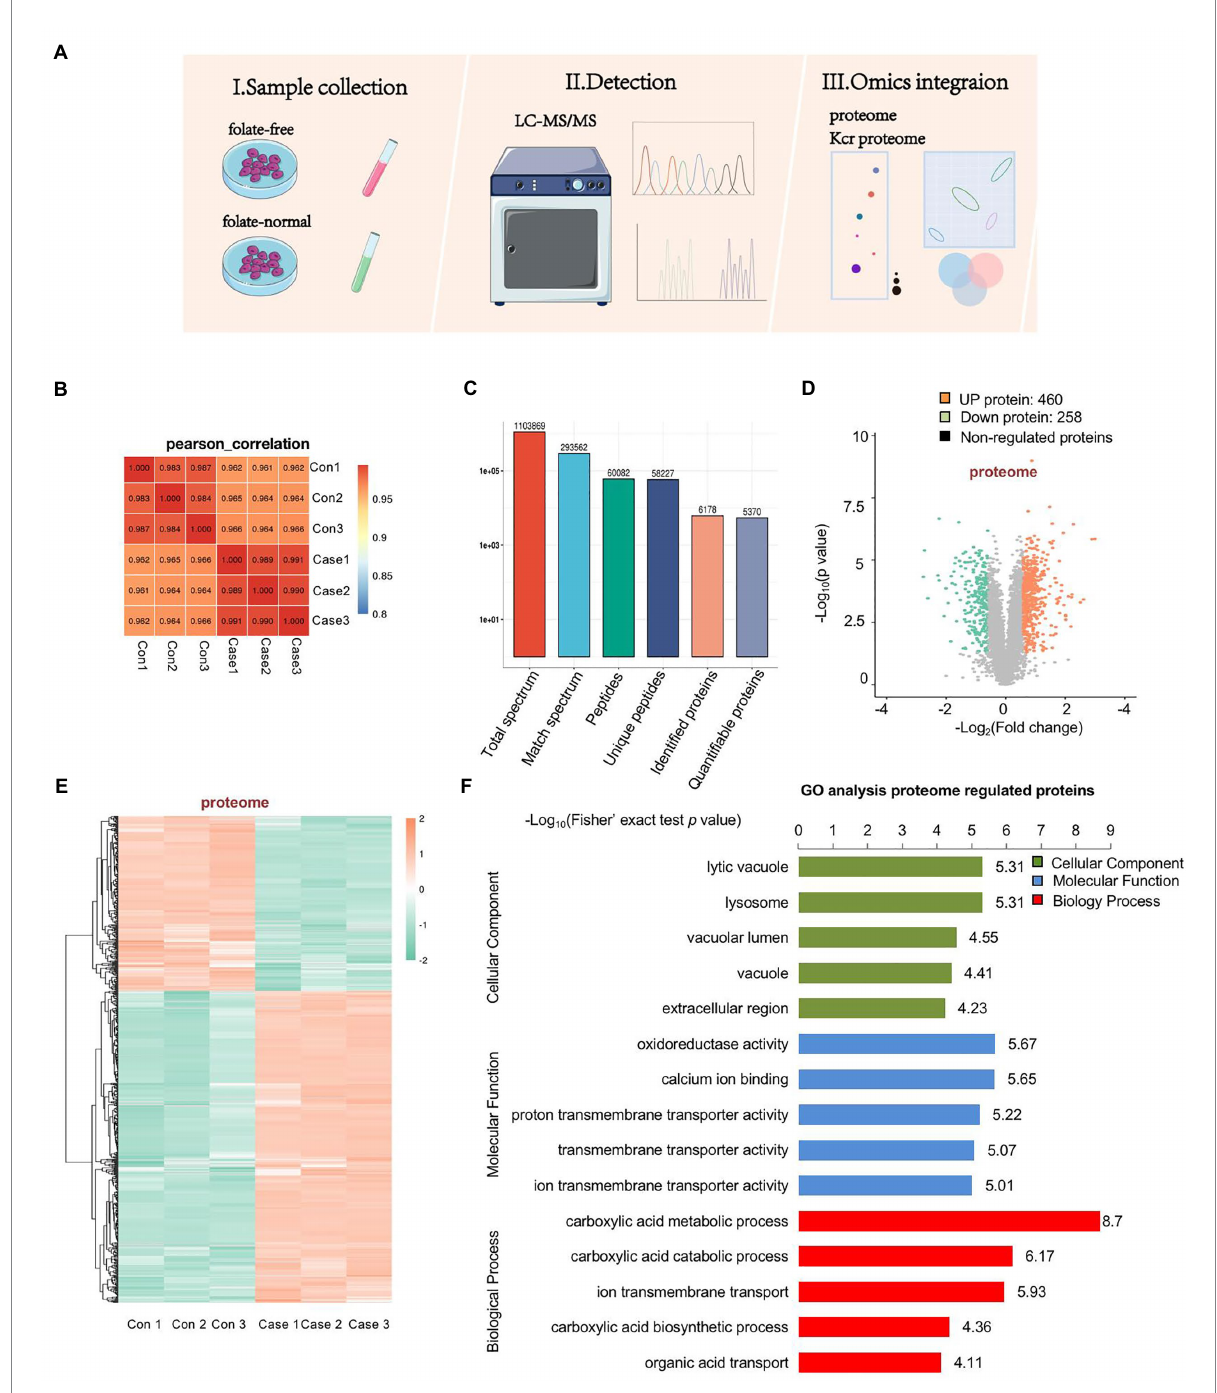
FIGURE 2 Profiling proteomics of folate-free mESCs. (A) The flow chart depicted the experimental procedures and data analysis workflow. (B) Heat maps are drawn with Pearson correlation coefficients between all samples. Pearson correlation coefficient is negative correlation when it is close to − 1, positive correlation when it is close to 1, and no correlation when it is close to 0. (C) An overview of protein identification. (D) Volcano plot showing double thresholds for DEPs in normal folate (4 mg/l) versus folate-free conditions (0 mg/l). Green dots indicate a decrease protein, and red indicates an increase protein in abundance (FC ≥ 1.40 or ≤ 0.71, p < 0.05). (E) Hierarchical clustering heatmap depicting individual samples and protein expression differences between normal folate versus folate-free mESCs (n = 3 per group). (F) Bar chart of the DEPs organized by enriched BP, CC, and MF, as determined with the Database for Annotation, Visualization, and Integrated Discovery